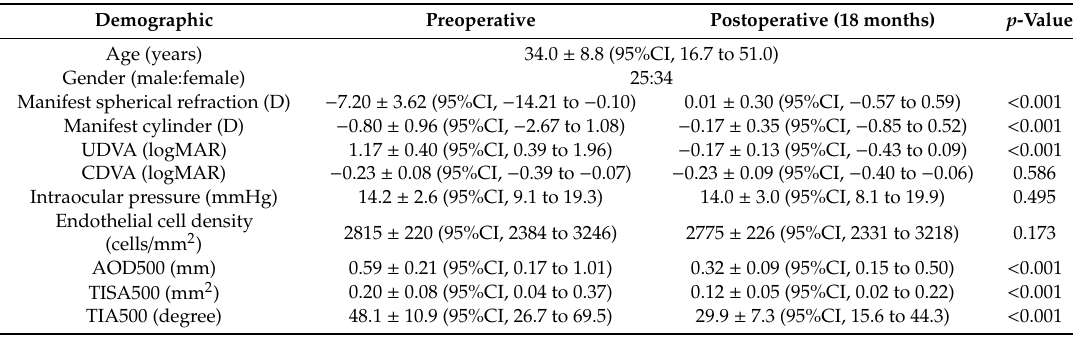
Table 1. Preoperative and postoperative demographics of the study population undergoing implantable collamer lens